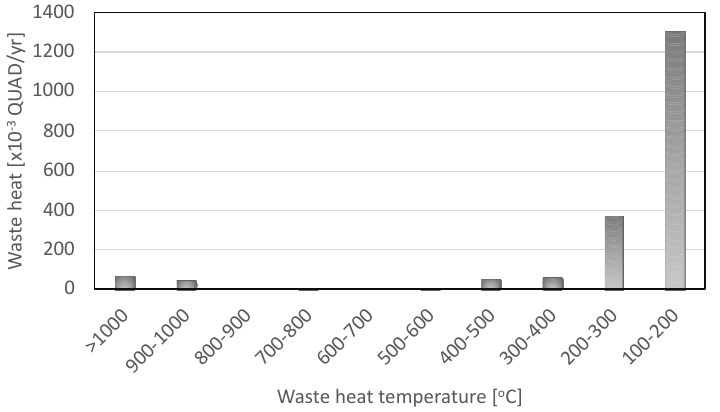
Figure 1. Waste heat temperature distribution from industrial processes in the U.S. in 2008, adopted from Table 20 in the Ref. [7].